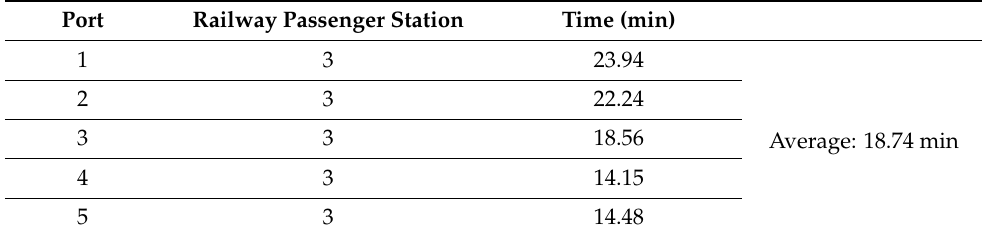
Table 4. Planning port-railway passenger station transfer time statistics.